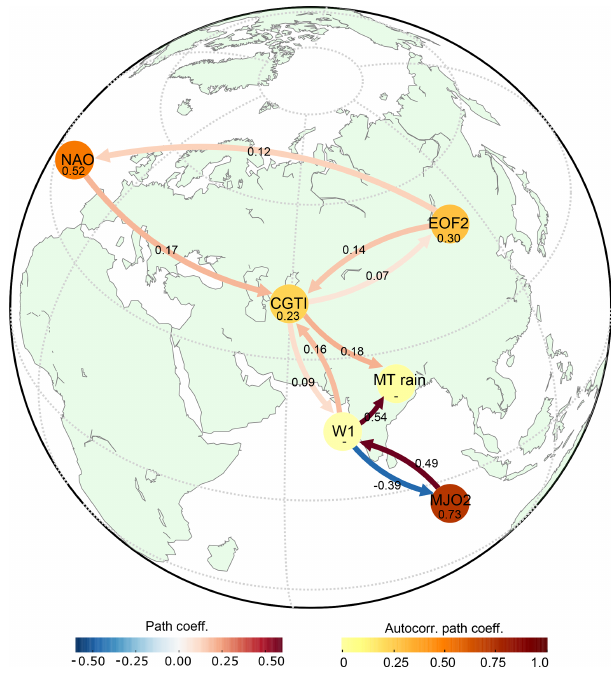
Figure 7. Combined mid-latitude and tropical causal interactions of ISM. CEN built with W1, MJO2, MT rainfall, NAO, CGTI and EOF2 for the period 1979–2017. The strengths of causal links ex- pressed by the standardized regression path coefficients and auto- correlation path coefficients are shown above the arrows and inside the circles, respectively. All links have a lag of 1 week. Only causal links with corrected p < 0 . 05 are shown. See the main text for dis-